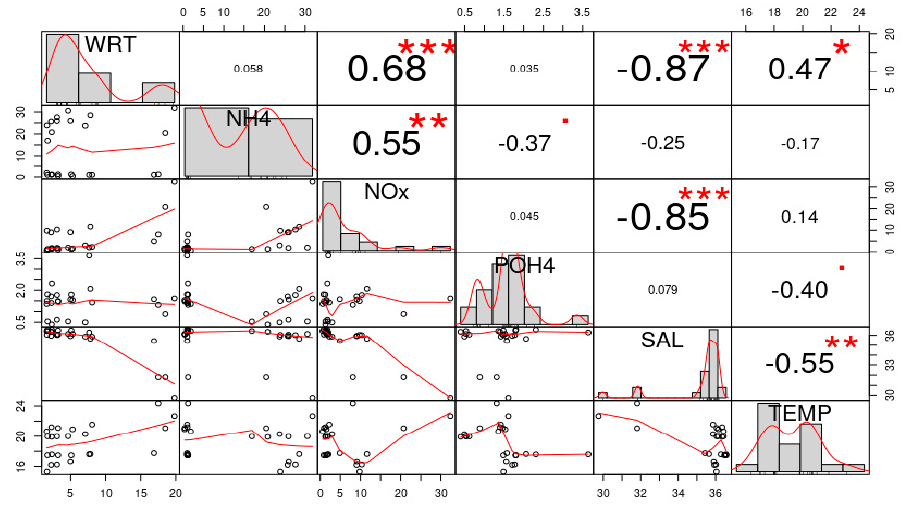
Figure 7. Correlation matrix between monthly WRT and water quality parameters (Ammonium, Nitrate, Phosphate, salinity, temperature) (High tide). The distribution of each variable is shown on the diagonal. On the bottom of the diagonal: the bivariate scatter plots with a fitted line are displayed. On the top of the diagonal: the value of the correlation plus the significance level as stars. Each significance level is associated to a symbol: p -values (0, 0.001, 0.01, 0.05, 0.1, 1) <=> symbols (“***”, “**”, “*”, “.”, “ ”).